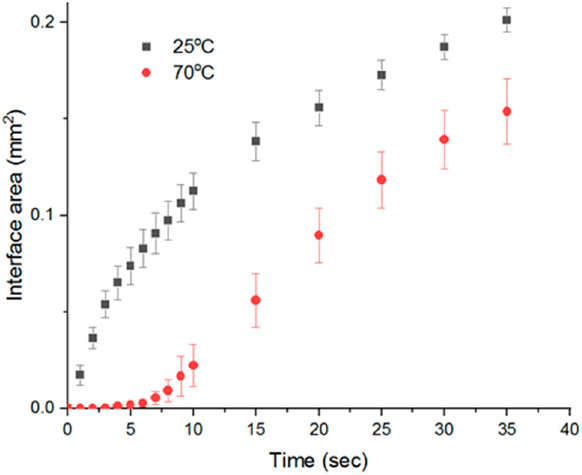
Figure 5. Comparison of macrovoid growth rate at 25 and 70 °C.